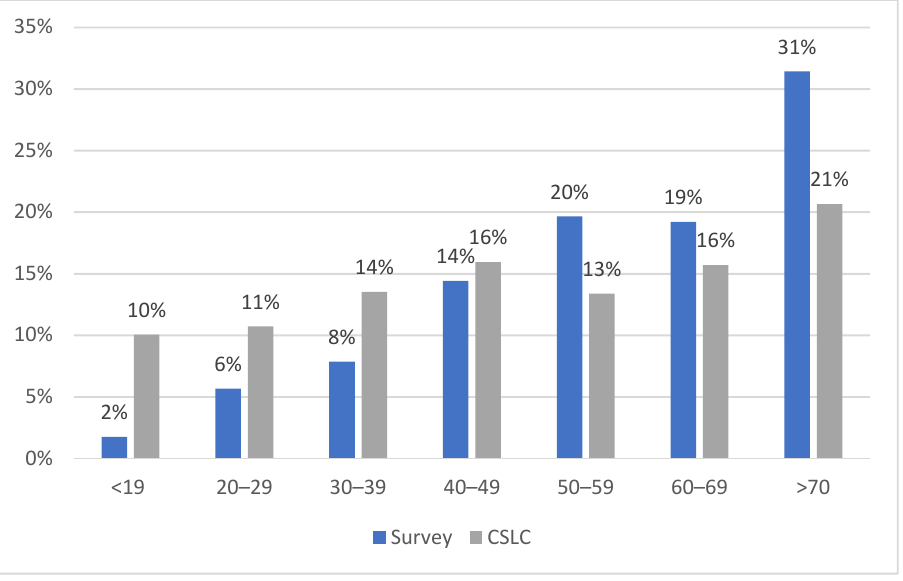
Figure 5. Distribution of distance from wind turbines to residences. Figure 6 graphically summarizes factors of the residential environment related to the presence of wind turbines and other large buildings, such as visibility and audibility. With regard to visibility, we asked respondents, “How many wind turbines can you see from your home?” and totaled how many saw at least one. We found that almost half of the respondents could see wind turbines from their homes. We also asked, “Do you have any large structures (e.g., towers, factories, large shopping centers) near your home?” We found that large buildings were visible from 44% of respondents’ homes. Regarding the sound, we asked, “Do you hear the sound of wind turbines (e.g., blades blowing in the